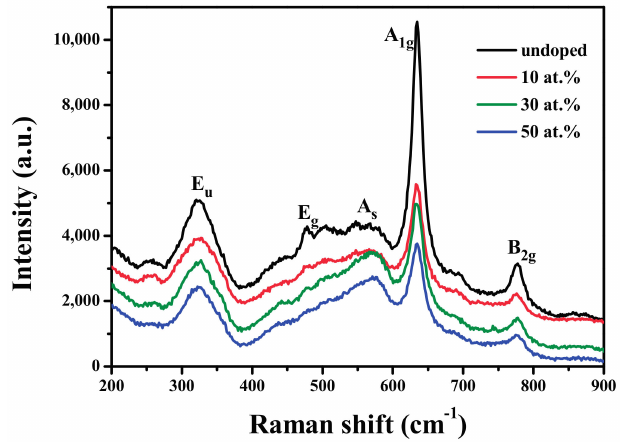
Figure 3. Raman spectra of SnO 2 and FTO